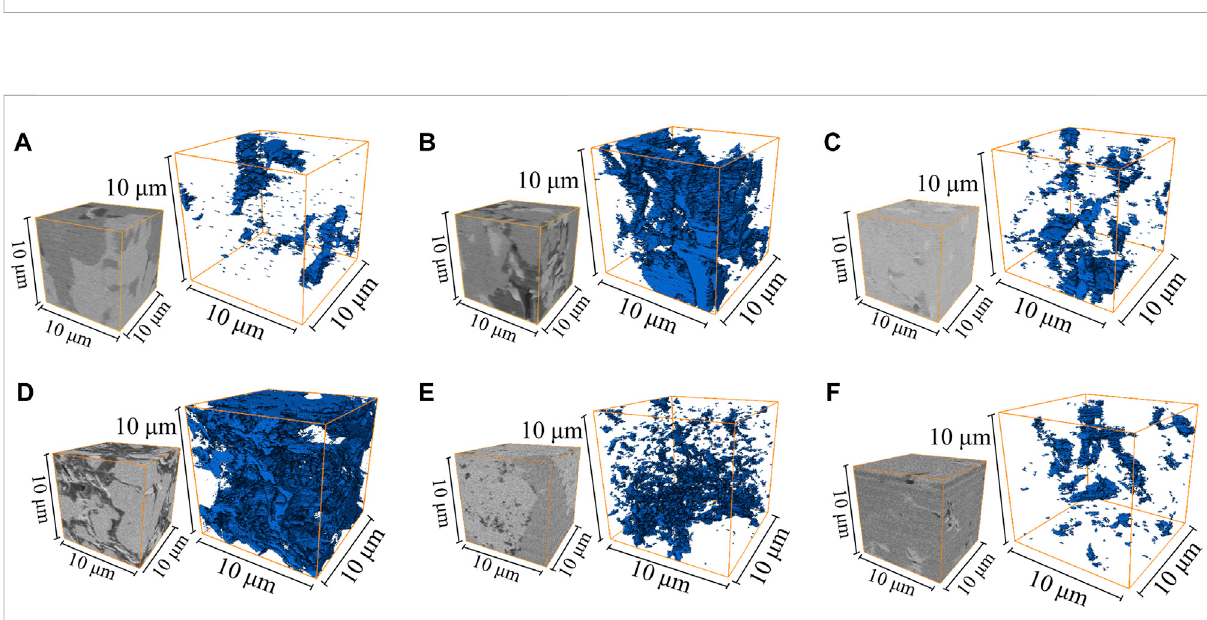
FIGURE 4 Porosity evolution with the increasing model size, showing the size of the representative volume element (REV) of Sample G1 (A) and Sample G2 (B) at an upsizing of 120